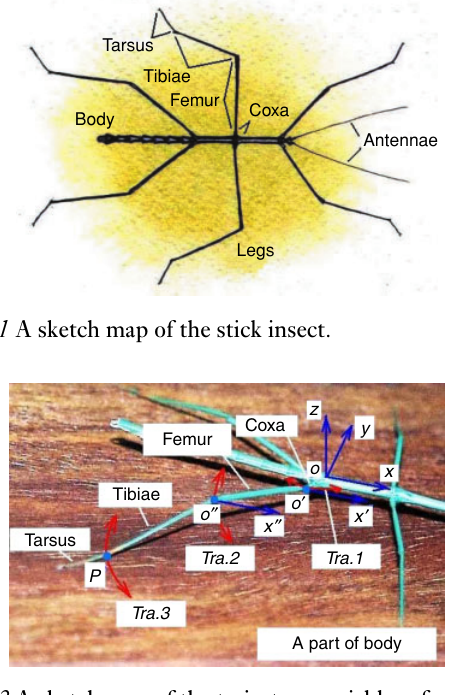
Figure 2 A sketch map of the trajectory variables of one stick insect leg.